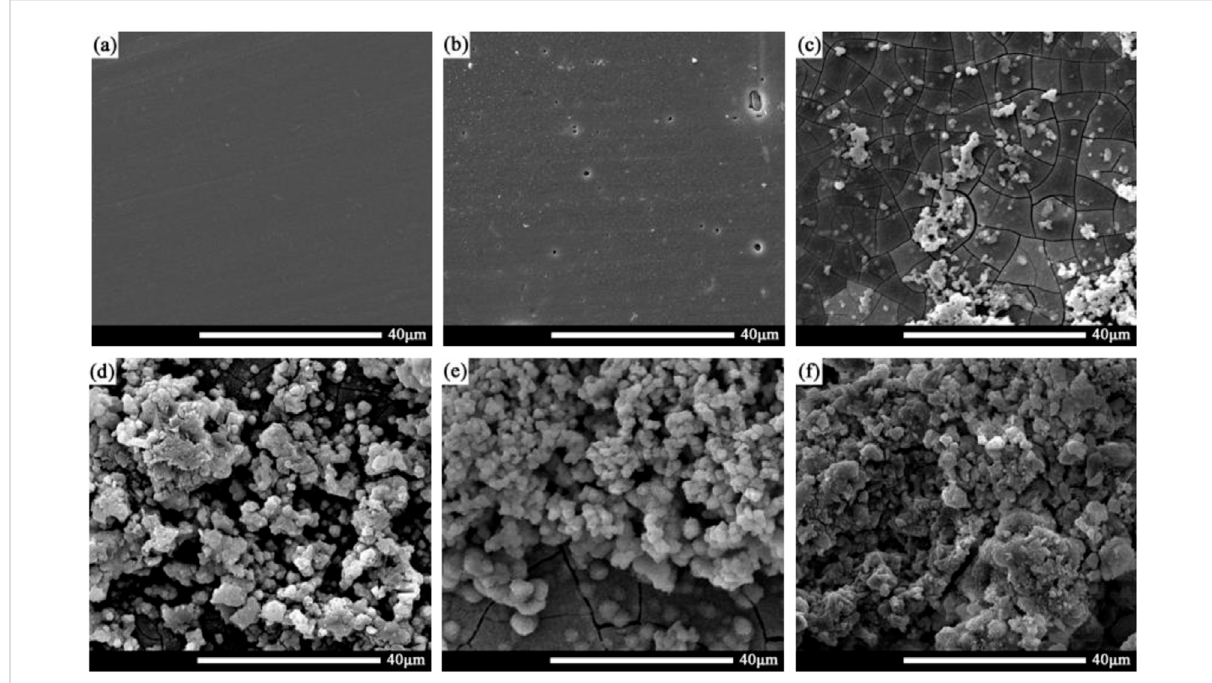
FIGURE 4 Corrosion products of 2060-T4 Al-Li alloy samples with different immersion time, (A) 0 h, (B) 6 h, (C) 24 h, (D) 72 h, (E) 168 h, (F) 720